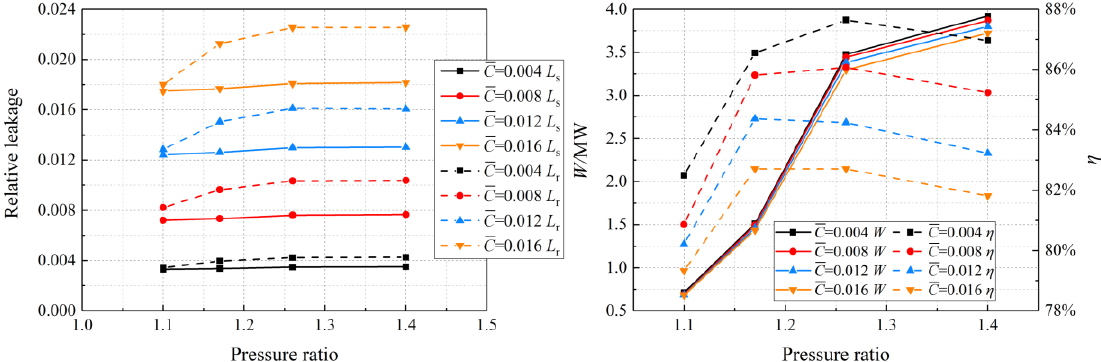
Figure 9. Variations of performance parameters under different seal clearance with pressure ratio (left: relative leakage; right: power and efficiency).